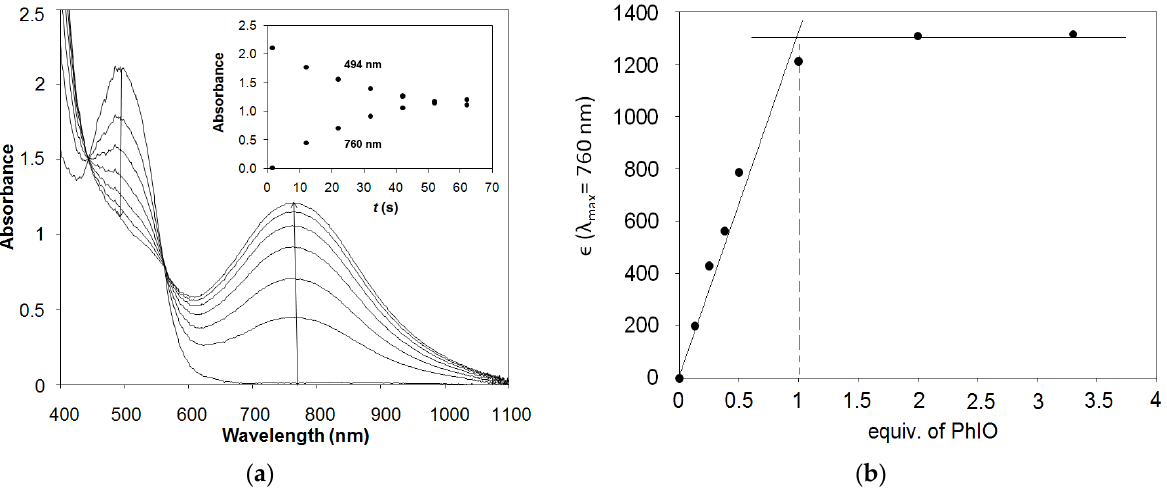
Figure 6. Spectral changes during the reaction of 3 with mCPBA: ( a ) UV-vis absorption spectra of complex 3 after addition of 1 equiv. of mCPBA. Conditions: [ 3 ] = 1 mM in MeCN at 5 °C, Δ t = 1 s.; ( b ) Titration of 3 with 0.2, 0.4, 0.6, 0.8, 1, 1.25, and 1.75 equiv. of mCPBA. Conditions [ 3 ] = 1 mM in MeCN at 5 °C, λ = 760 nm.